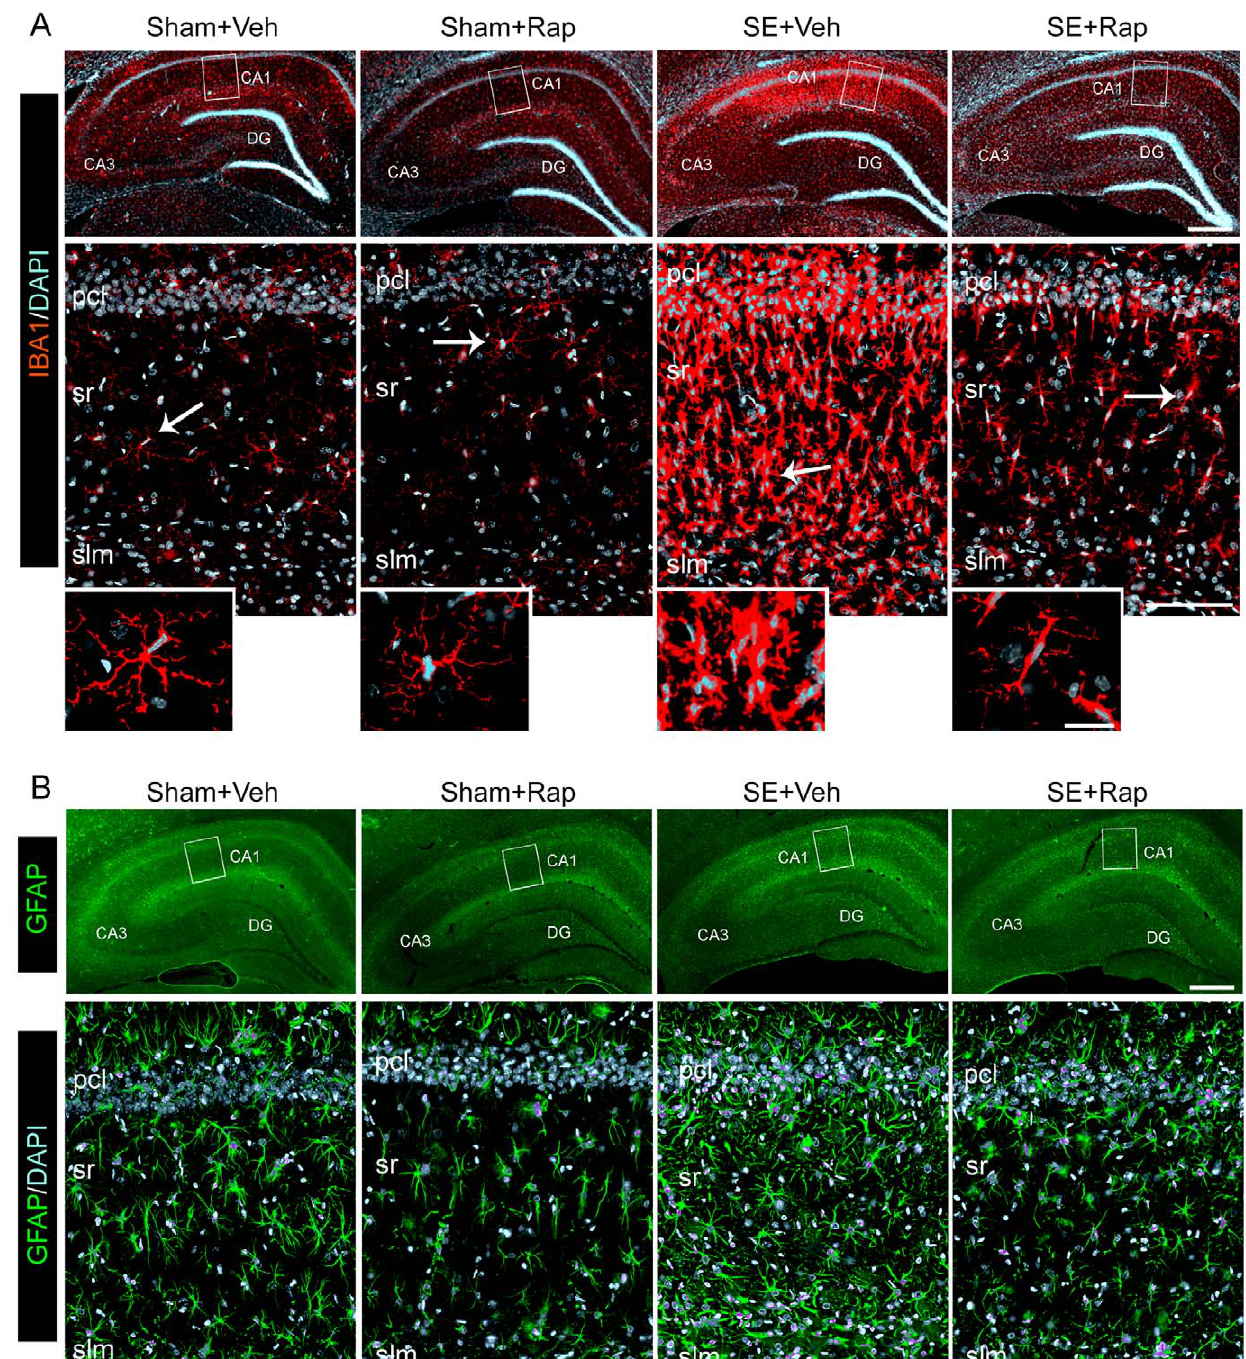
Figure 6. Rapamycin reduced SE-induced hippocampal gliosis. ( A–B ) We used immunohistochemistry to evaluate the distribution of staining for IBA1 (for microglia) ( A ) and GFAP (for astrocytes) ( B ). Immunostaining was performed in hippocampi from SE and sham rats after treatment with rapamycin (Rap) or vehicle (Veh), following behavioral tests. ( A – B top panels) Representative low power images with IBA1 (red) ( A ) and GFAP (green) ( B ) staining within the CA1 and DG regions is shown. DAPI (blue) shows nuclear staining. ( A – B bottom panels) Representative deconvoluted higher magnification projection images of the IBA1 ( A ) and GFAP ( B ) staining within CA1 pcl, sr, and slm. These images show a robust increase in IBA1 ( A ) and GFAP ( B ) staining in the CA1 area of the SE + Veh group that is drastically reduced in the SE + Rap group. Insets in A show IBA1-stained microglia with branched processes and small cell bodies in the Sham + Veh, Sham + Rap and SE + Rap groups, which in contrast are hypertrophied and amoeboid shaped in the SE + Veh group (arrows). Scale bars: A , B top panels: 500 m m; A , B bottom panels: 100 m m; deconvoluted maximum projection images are from 21 Z-stacks (0.5 m m steps). Abbreviations: pcl, pyramidal cell layer; sr, stratum radiatum; slm, stratum lacunosum moleculare; gcl, granule cell layer; DG, dentate gyrus; n=6.